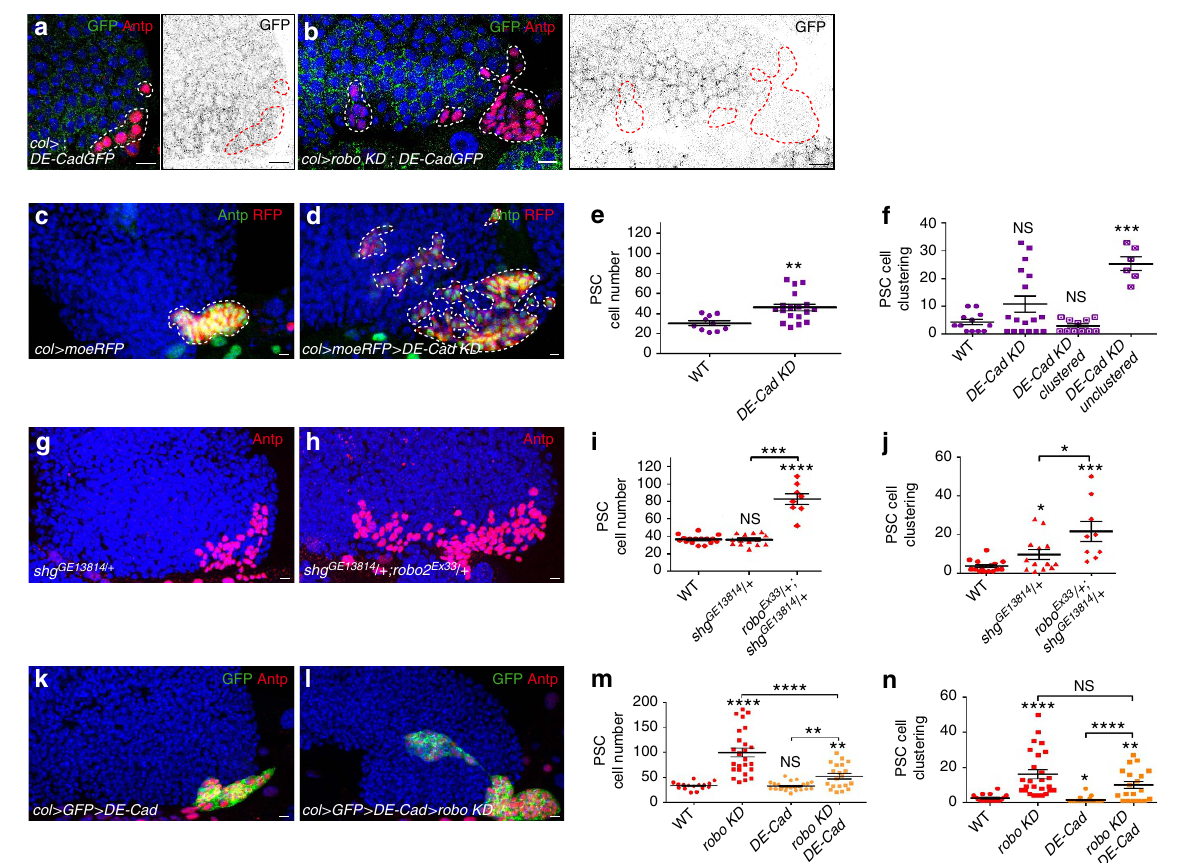
Figure 5 | Robo receptors control the number and clustering of PSC cells via DE-cadherin. ( a , b ) L2/early L3 LGs where DE-cadherin-GFP (green in left panels; black in right panels) is expressed in PSC cells labelled by Antp (red). Compared with WT ( a ) robo KD LGs ( b ) express a lower level of DE-cadherin-GFP in the PSC. ( c , d ) Antp (green) and RFP ( col 4 moeRFP , red) label PSC cells in control ( c ) and in col 4 DE-cadherin KD PSC ( d ). ( e , f , i , j , m , n ) Quantification of PSC cell numbers ( e , i , m ) and PSC cell clustering ( f , j , n ) in various mutant conditions. Reduction of DE-cadherin in the PSC ( d ) leads to an increased number of PSC cells compared with control ( c ). Averaging the clustering of all DE-Cad KD LGs ( n ¼ 44 lobes) does not reveal a significant clustering defect. However, these LGs can be divided into two classes: clustered (66%) and unclustered (33%), revealing a clustering defect ( f ). ( g , h ) Antp (red) labels the PSC in DE-cadherin mutant ( shotgun, shg ) shg GE13814 / þ heterozygote ( g ) and shg GE13814 / þ ; robo2 EX33 / þ trans -heterozygote mutant ( h ). A stronger PSC defect is observed in shg GE13814 / þ ; robo2 EX33 / þ trans -heterozygote compared with the single shg GE13814 / þ heterozygote mutant. For robo2 Ex33 / þ trans -heterozygote mutant, analysed in parallel to shg GE13814 / þ ; robo2 EX33 / þ trans -heterozygote, the quantification of PSC cell numbers and clustering for robo2 Ex33 / þ heterozygote is given in Fig. 1c,d. ( k , l ) Antp (red) and GFP (green) label PSC cells when DE-cadherin (DE-Cad) is overexpressed ( k ) or when robo KD and DE-cadherin are co-expressed in the PSC ( l ). Statistical analysis t -test (Mann–Whitney nonparametric test) is performed using GraphPad Prism 5